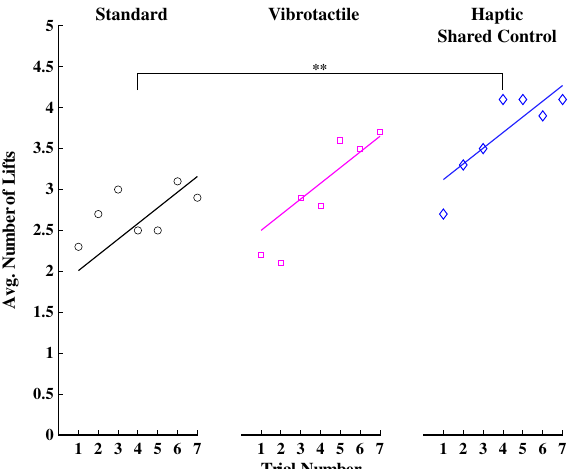
Figure 6. The average number of lifts for each group across trials, where the individual data points represent the average for each trial (for all participants in each group), and the solid lines indicate the model’s prediction. * indicates p < 0.05 , ** indicates p < 0.01 , and *** indicates p < 0.001 .